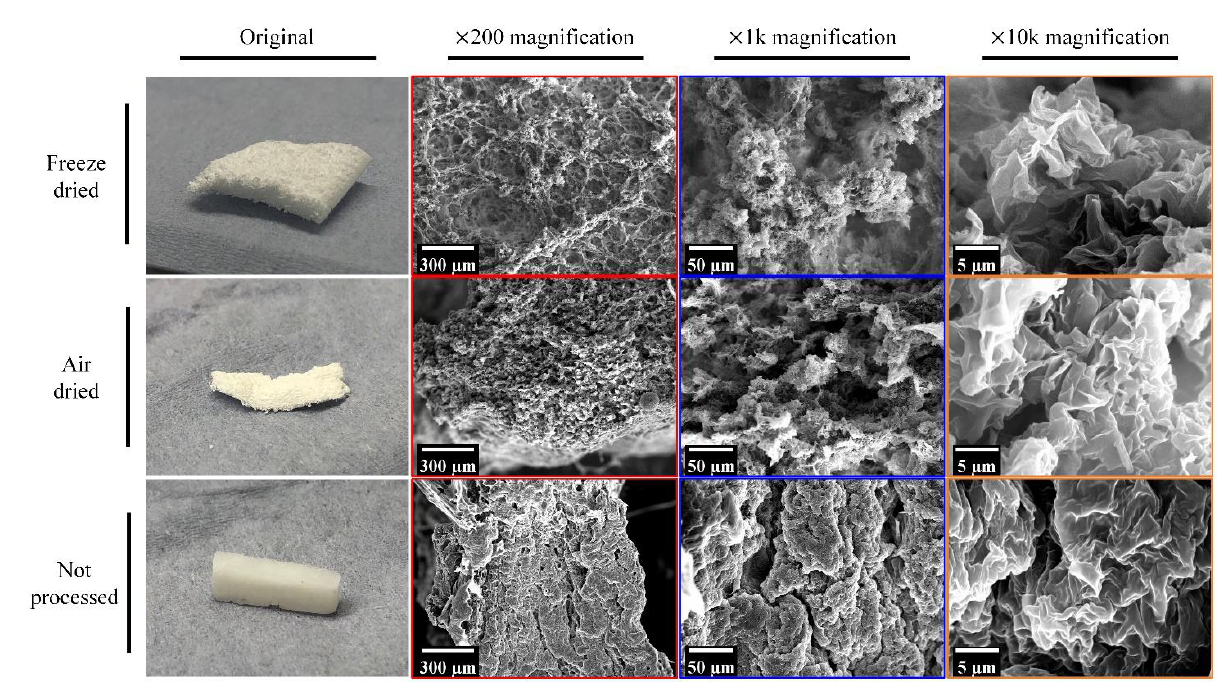
Figure 5. The influence of different drying process on the microstructure of the PCL/CS porous monoliths (G − CS12).